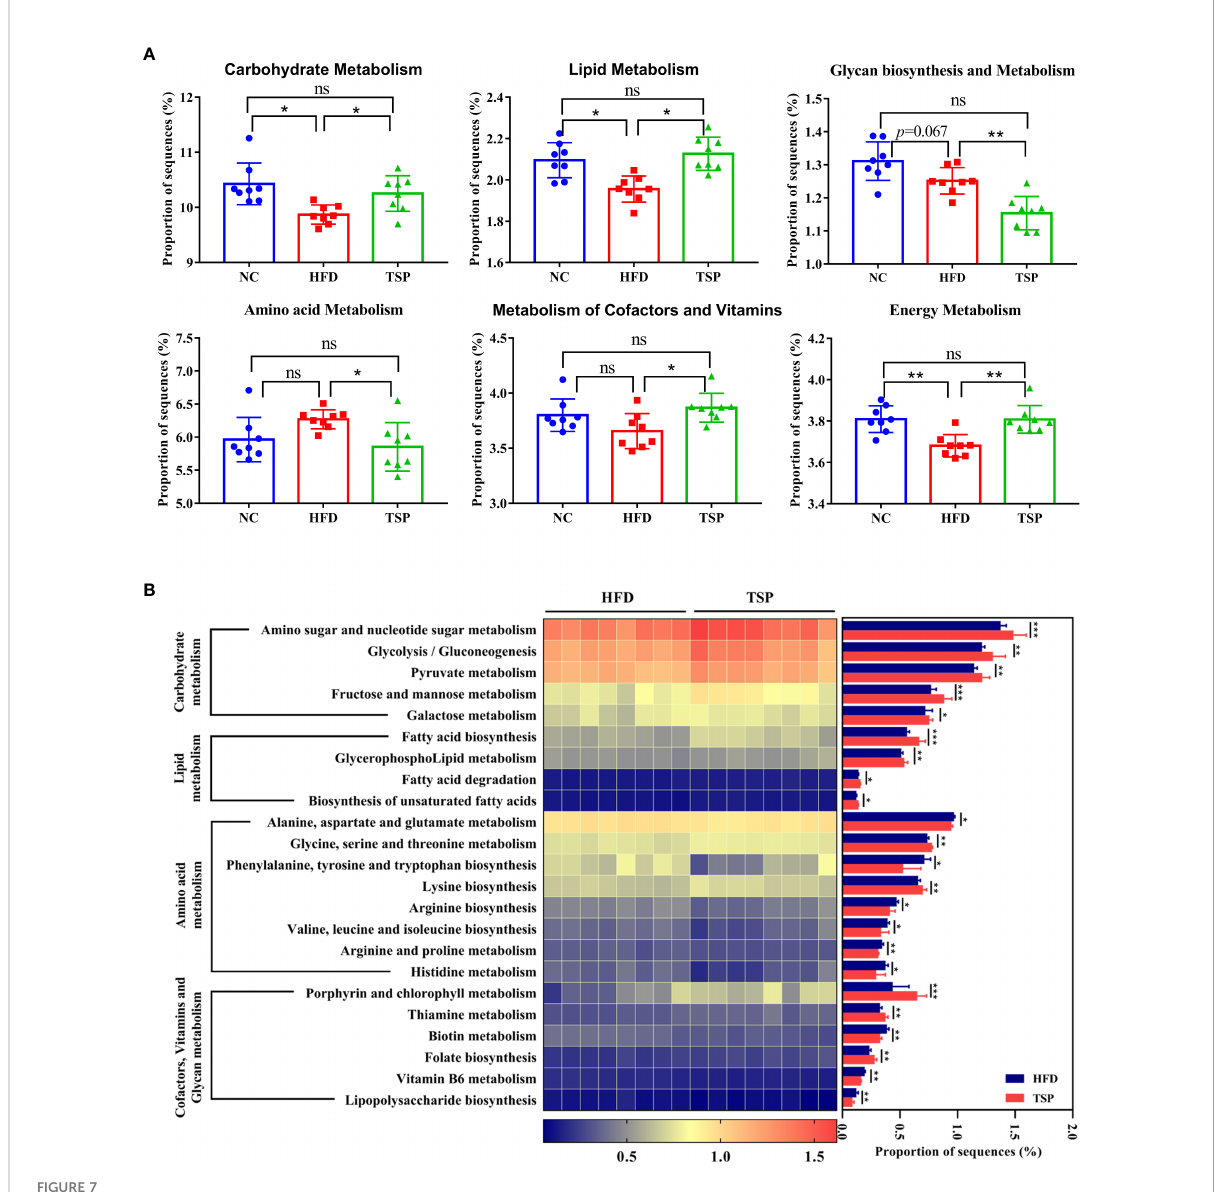
FIGURE 7 TSP supplementation induced function microbial changes in mice. (A) Abundances of top 6 KEGG pathways in level-2 of the functional prediction by PICRUSt, (B) Functional pro fi les with signi fi cant different between HFD and TSP treated groups. n = 8, * p < 0.05, ** p < 0.01, and *** p < 0.001, ns, no signi fi cant p >